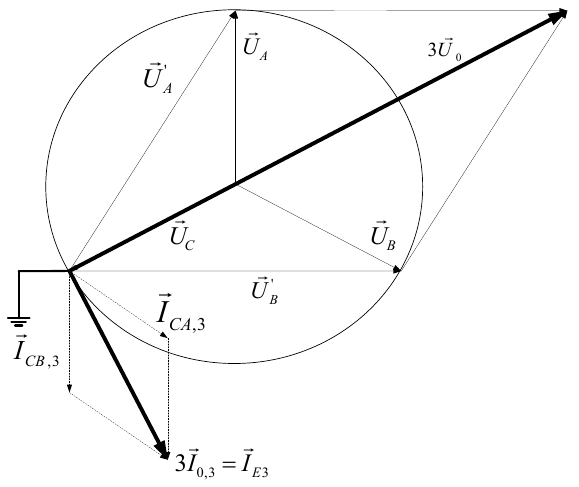
Figure 6. Vector diagram. Residual voltage and current in Line 3 with ground defect in Line